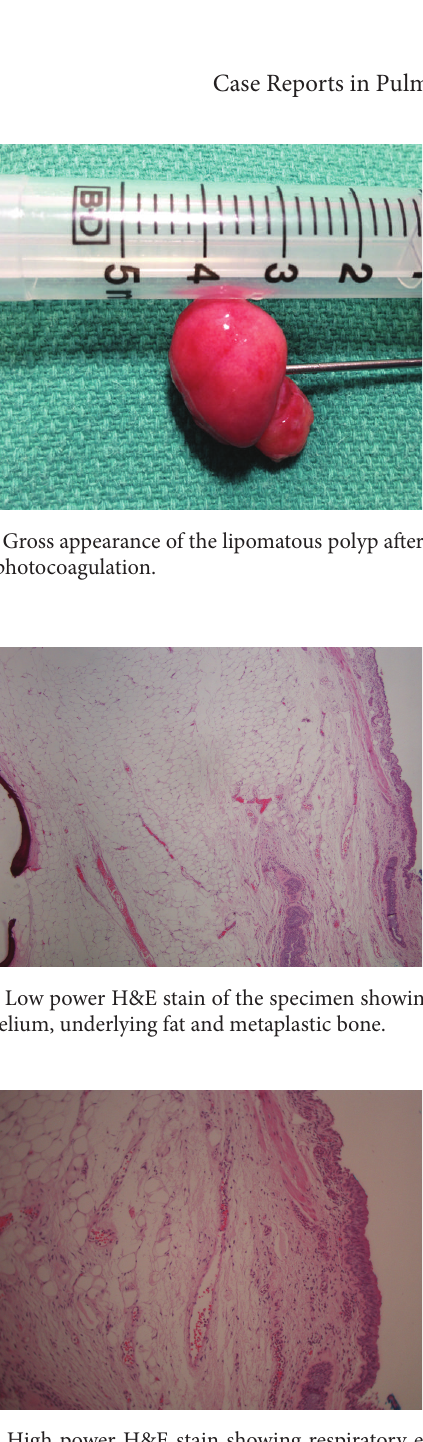
Figure 5: High power H&E stain showing respiratory epithelium and underlying